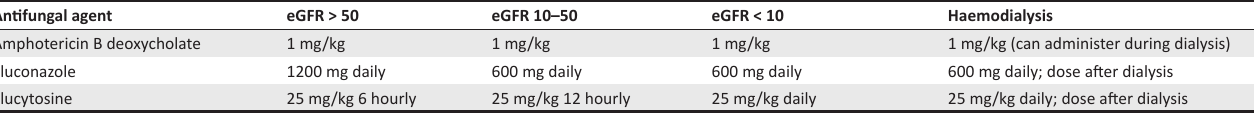
TABLE 6: Induction therapy doses of flucytosine, fluconazole and amphotericin B adjusted according to estimated glomerular filtration rates for adults. Antifungal agent